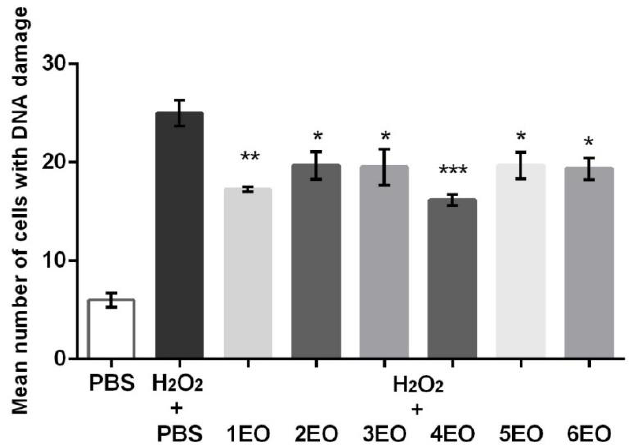
Figure 4. Antigenotoxic properties of essential oils of H. officinalis subsp. aristatus (1EO–6EO) against DNA damage in human peripheral blood leukocytes, induced by H 2 O 2 in post-treatment protocol. Bars represent the mean value of cells with DNA damage ± standard error of the mean (SEM) versus control treated with H 2 O 2 ( n = 3). PBS: phosphate-buffered saline solution. * p < 0.01, ** p < 0.001, *** p < 0.0001.